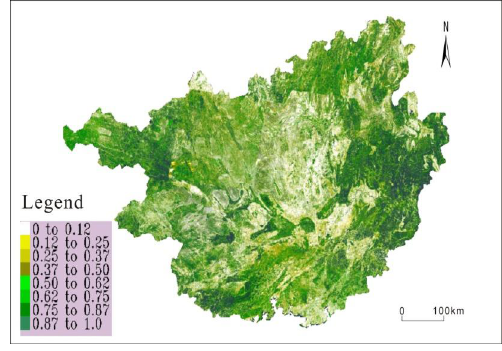
Figure 3. Guangxi vegetation cover